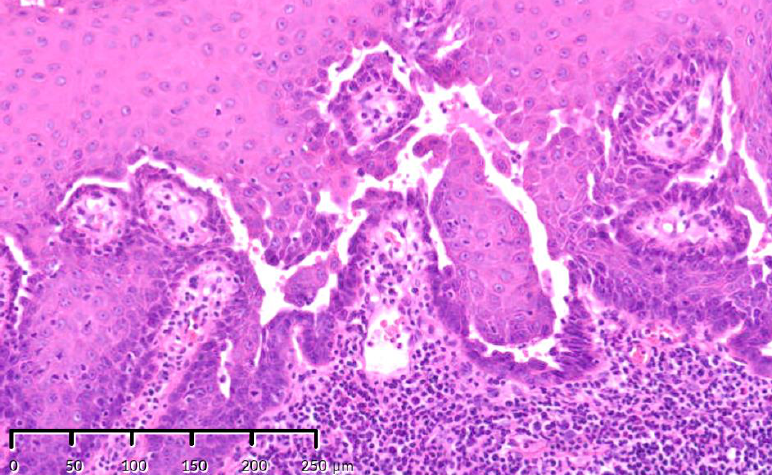
Figure 1. Intraoral photograph from the first visit: ( a ) Peri-implant ulcer, ( b ) oral lichenoid lesions of the bilateral buccal mucosa, ( c ) Nikolsky’s phenomenon of the gingiva, ( d ) pan- orama X-ray photograph (X-P), ( e ) dental X-P, and ( f ) 18 F-fluorodeoxyglucose positron emission tomography.